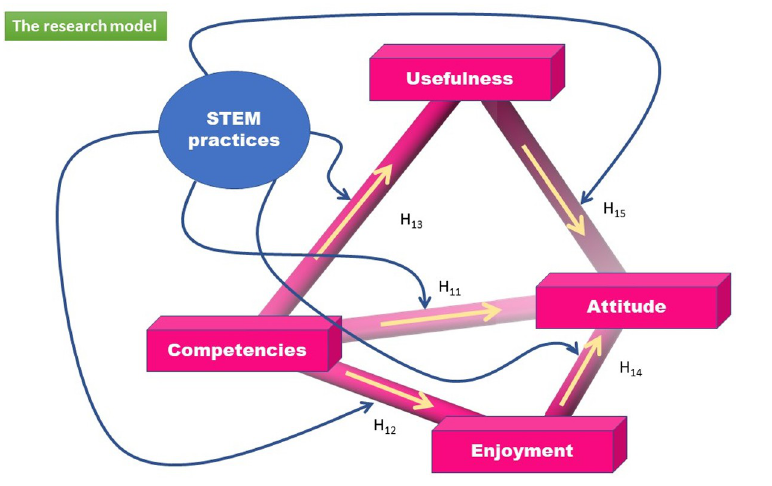
Fig 1. Diagram of the research